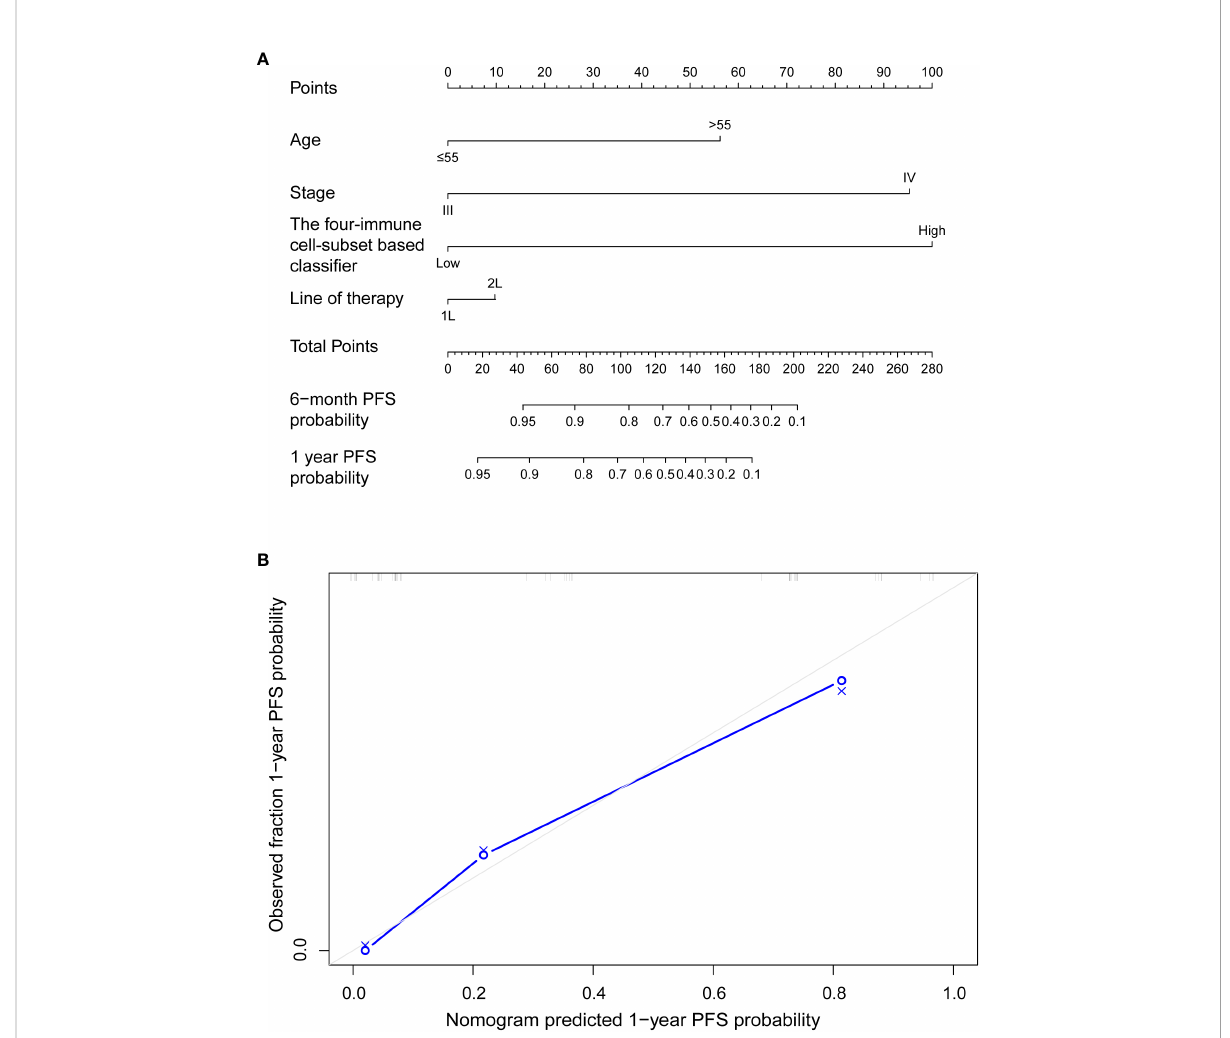
FIGURE 4 (A) Nomograms to predict risk of disease progression with anti-PD-1 inhibitor-based treatment in advanced malignant melanoma patients. (B) Plots depict the calibration of each model in terms of agreement between predicted and observed 1-year outcomes. Model performance was shown by the plot, relative to the 45° line, which represents perfect